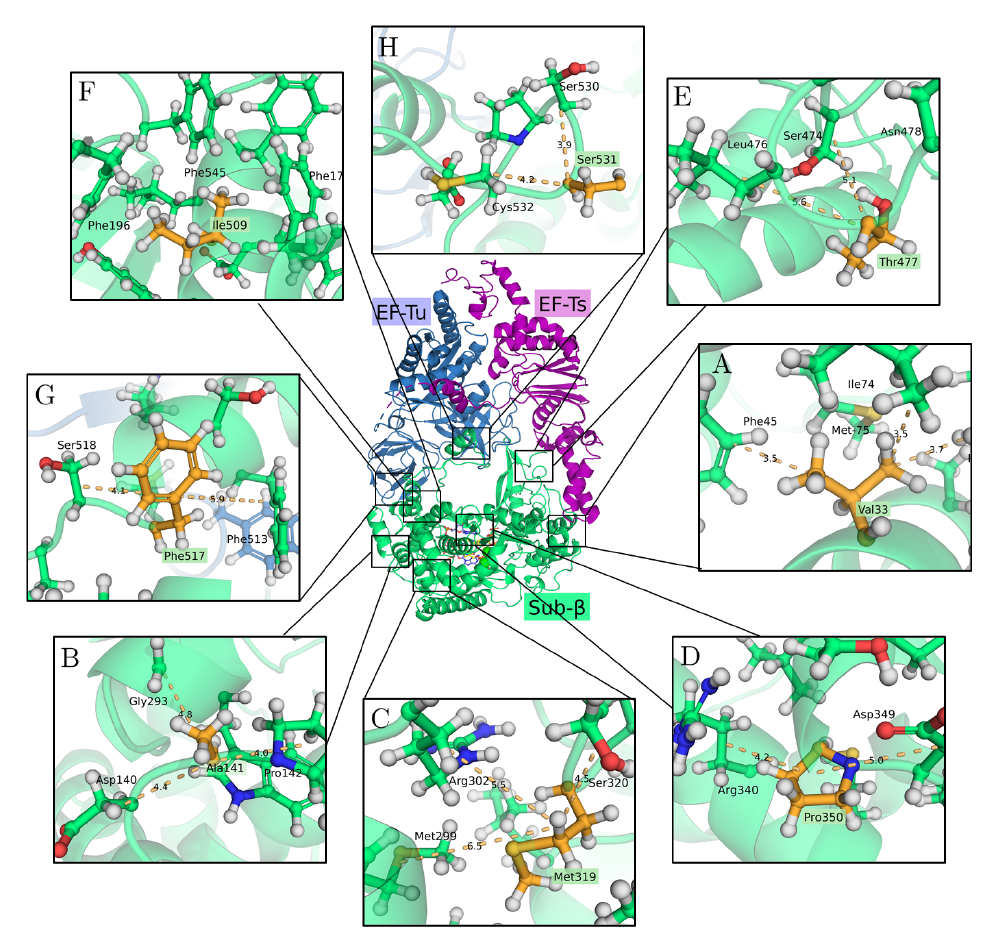
Figure 2. Localization of various non-silent mutations in the structure of the Q β replicase. Mutations in green were found in the consensus sequences of different populations (see Table A1). We high- lighted the closest residues and the distance (in Å) between such residues and the fixed mutation. The new residue is shown in orange and the side chains of the closest amino acids are shown in green. EF: Elongation factors of the cell that belong to the replication complex. Sub- β : β subunit of the viral replicase. As usual, nitrogen atoms appear in blue and oxygen atoms appear in red. ( A – H ): See the main text for details on each